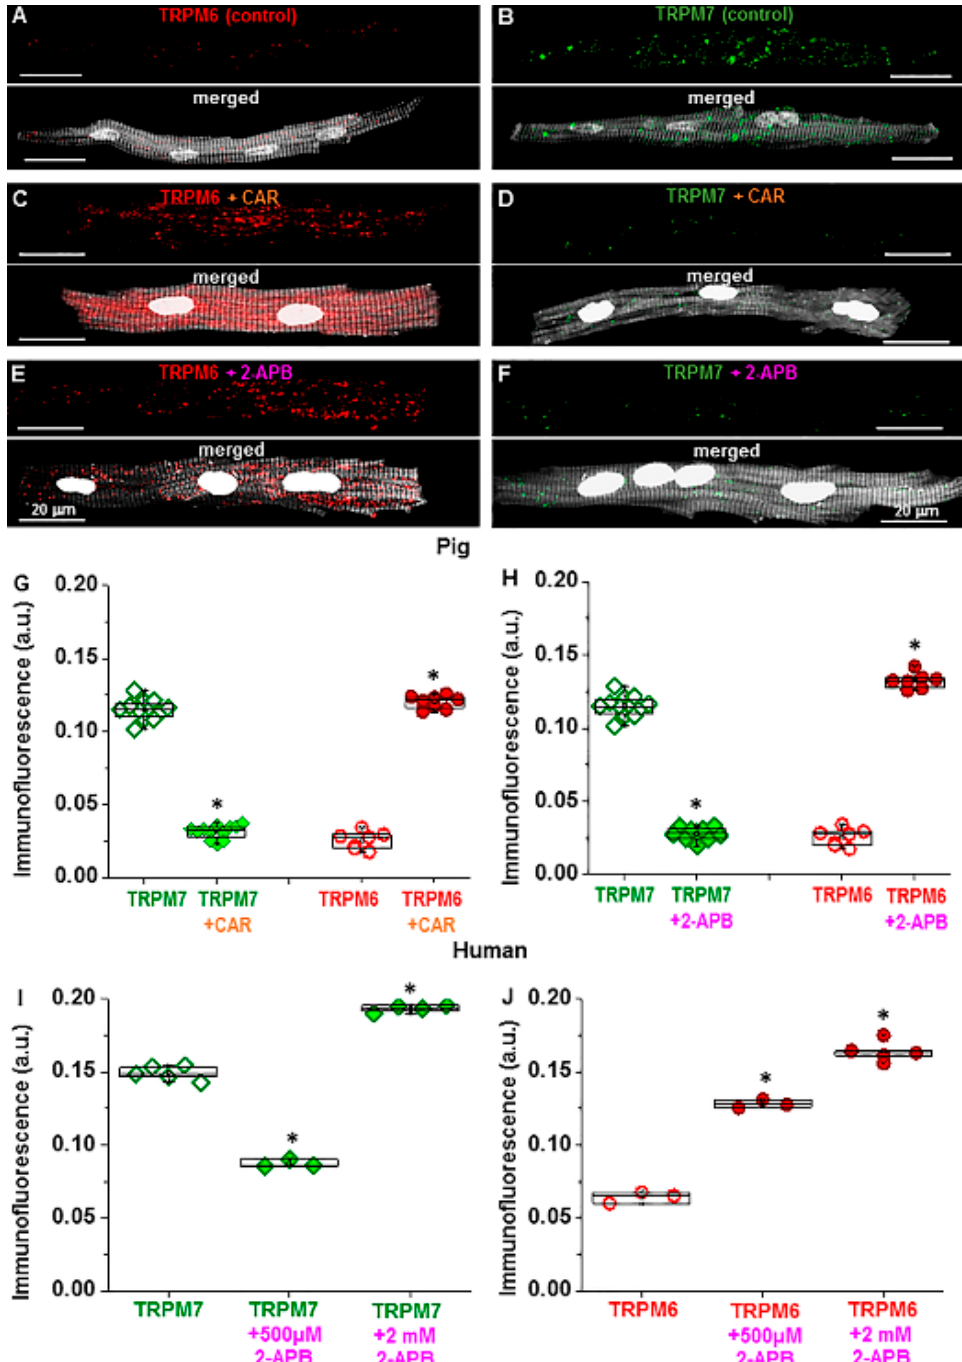
Figure 4. Effect of TRP channel modulating drugs carvacrol (CAR) or 2-aminoethoxydiphenyl borate (2-APB) on detected TRPM6 and TRPM7 in pig and human RA cardiomyocytes: ( A – F ) Immunofluorescence of TRPM6 and TPRM7 in pig cardiomyocytes under control conditions and in the presence of CAR or 2-APB. Scale bars indicate 20 µm; ( G , H ) quantification of the immunodetected TRPM7 and TRPM6 proteins in pig RA cardiomyocytes in the absence (unfilled symbols) or in the presence (filled symbols) of either CAR ( G ) or 2-APB ( H ); ( I , J ) quantification of the immunodetected TRPM7 ( I ) and TRPM6 ( J ) proteins in human RA cardiomyocytes in the absence (unfilled symbols) or presence (filled symbols) of 2-APB at either 500 µM or 2 mM. Fluorescence intensity expressed in arbitrary units (a.u.). * p < 0.001 for drug vs. no drug. Notice opposite changes on TRPM7 with 2-APB at 500 µM vs. at 2 mM.